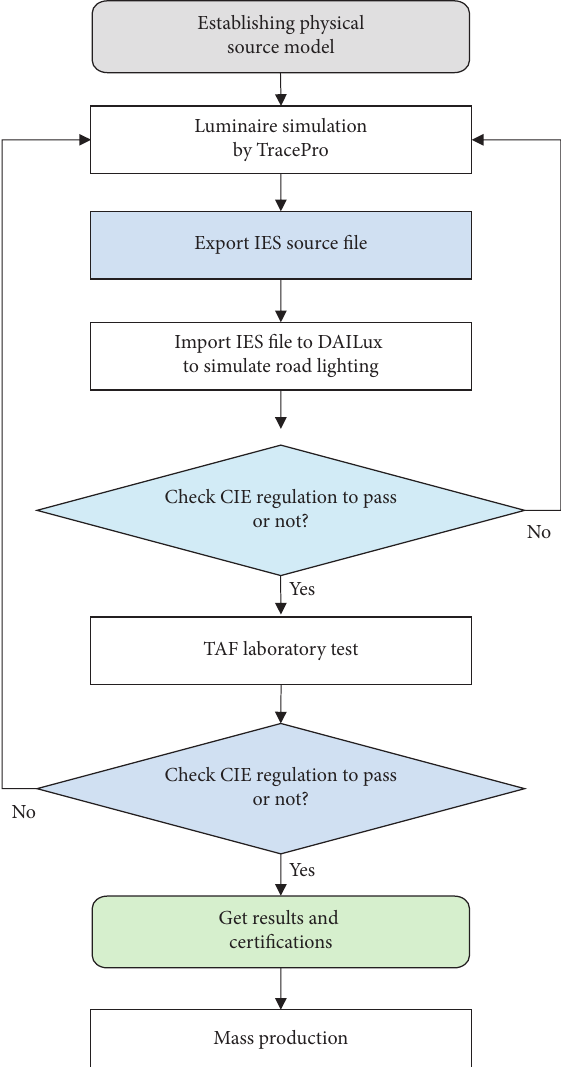
Figure 14: Flow chart of freeform-surface streetlight luminaire